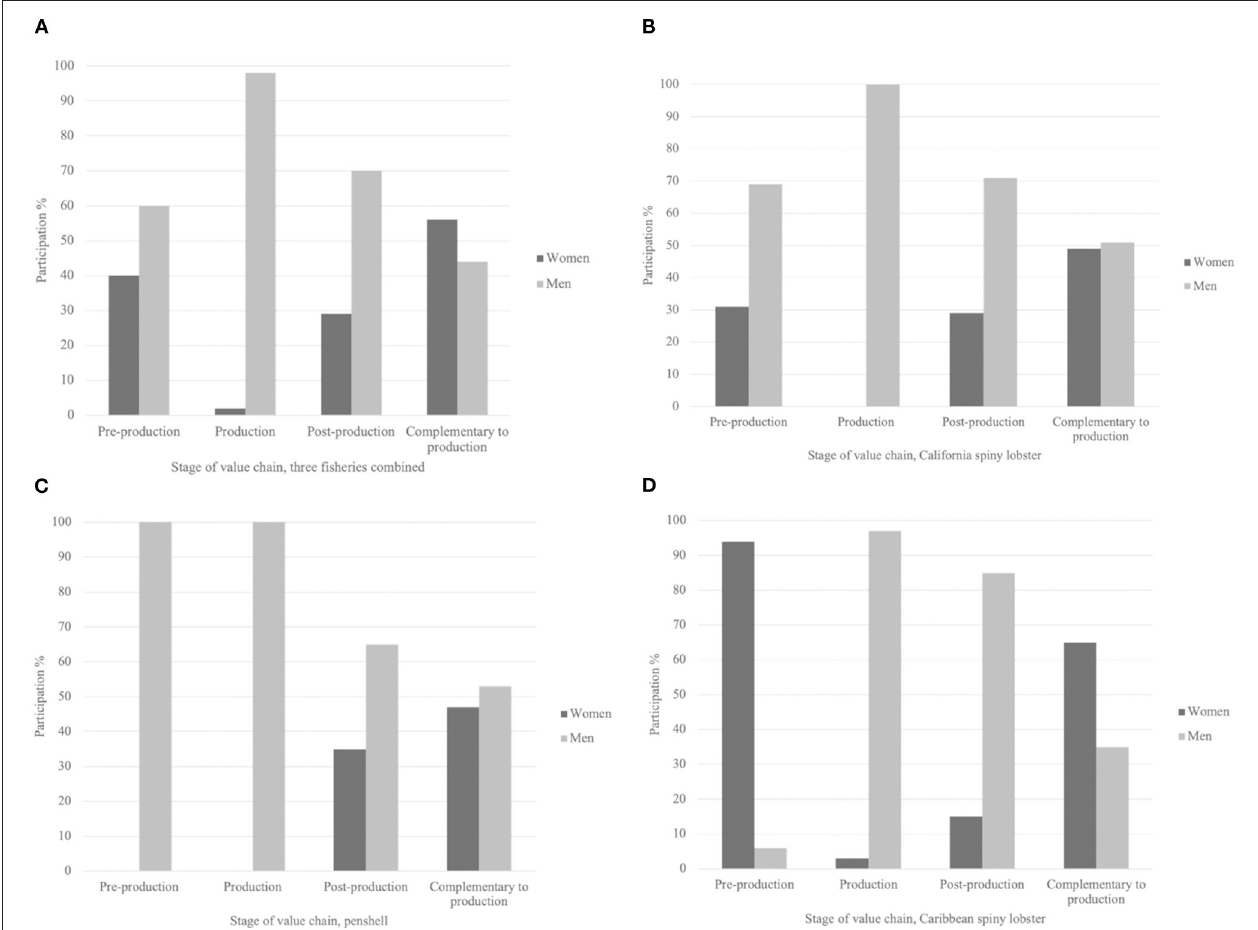
FIGURE 3 | Participation in value chain, with the three fisheries combined (A) , and specific to California spiny lobster (B) , penshell (C) , Caribbean spiny lobster (D) fisheries.